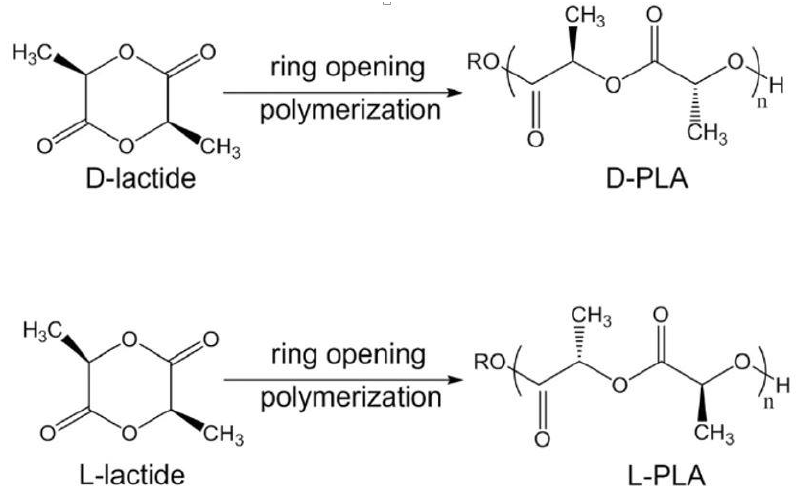
Figure 2. Stereoisomers of the polymer start from different lactides. Reproduced with permission from [28] (License number: 5235811357024).